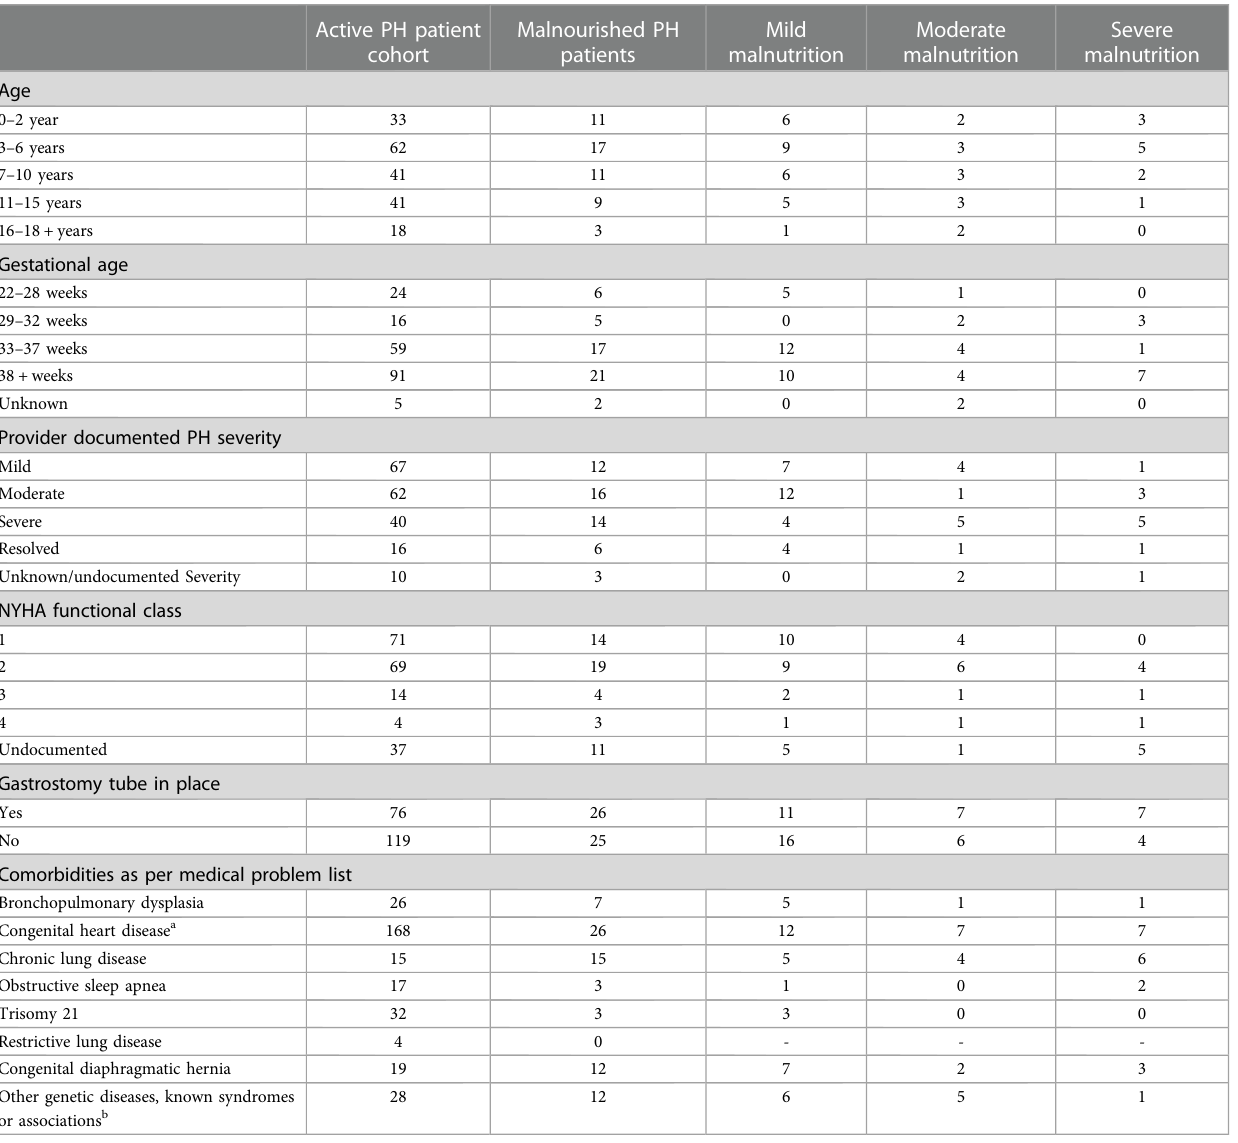
TABLE 1 Patient